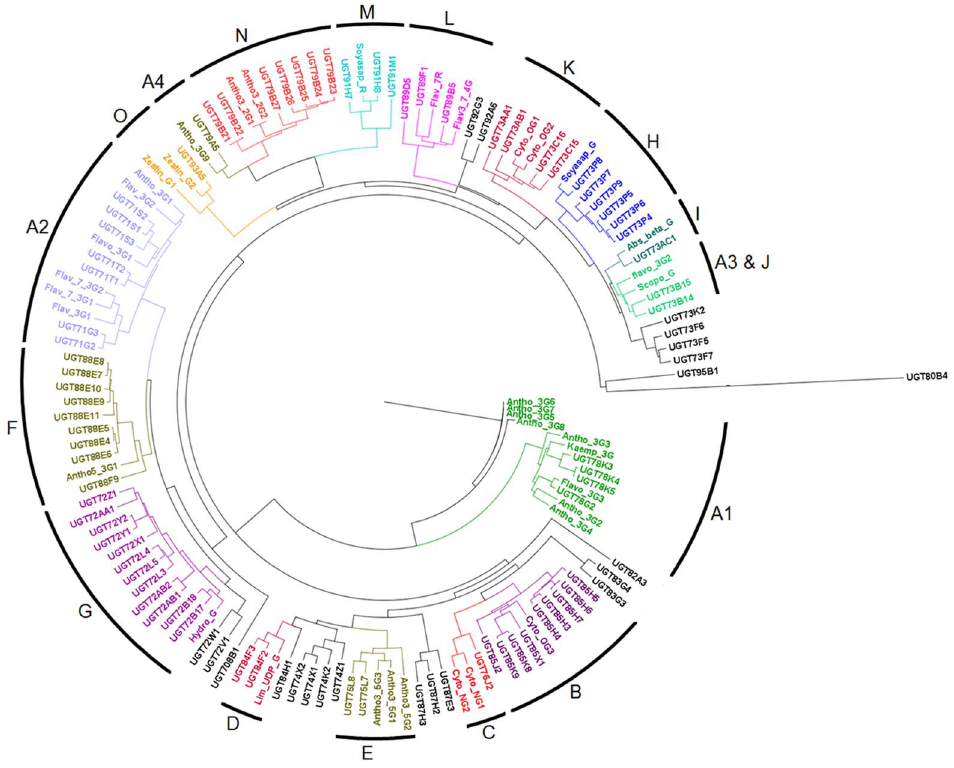
Figure 4. Functional annotation of Ca UGTs. Dendrogram showing clustering of 96 Ca UGTs with 38 well characterized UGT proteins from other plant species. The image shows distinct clustering of Ca UGTs with the functionally related UGTs.